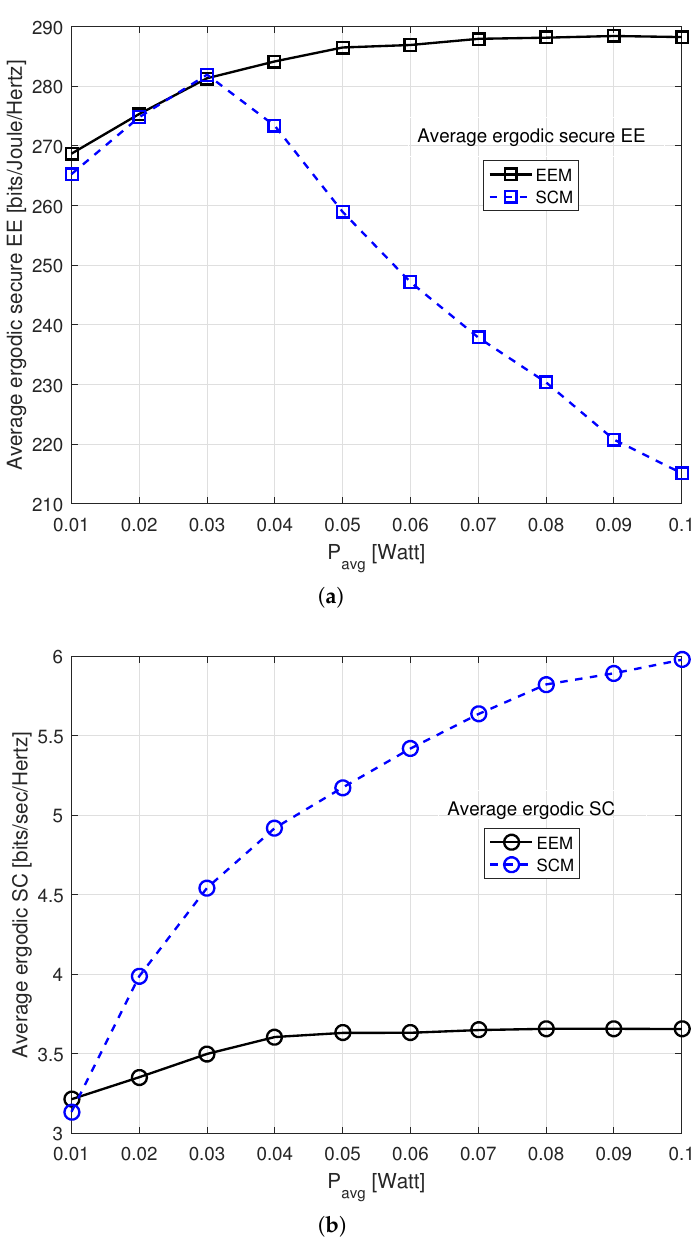
Figure 3. Average ergodic secure EE and SC of SU versus P avg . ( a ) Average ergodic secure EE of SU versus P avg , ( b ) Average ergodic SC of SU versus P avg